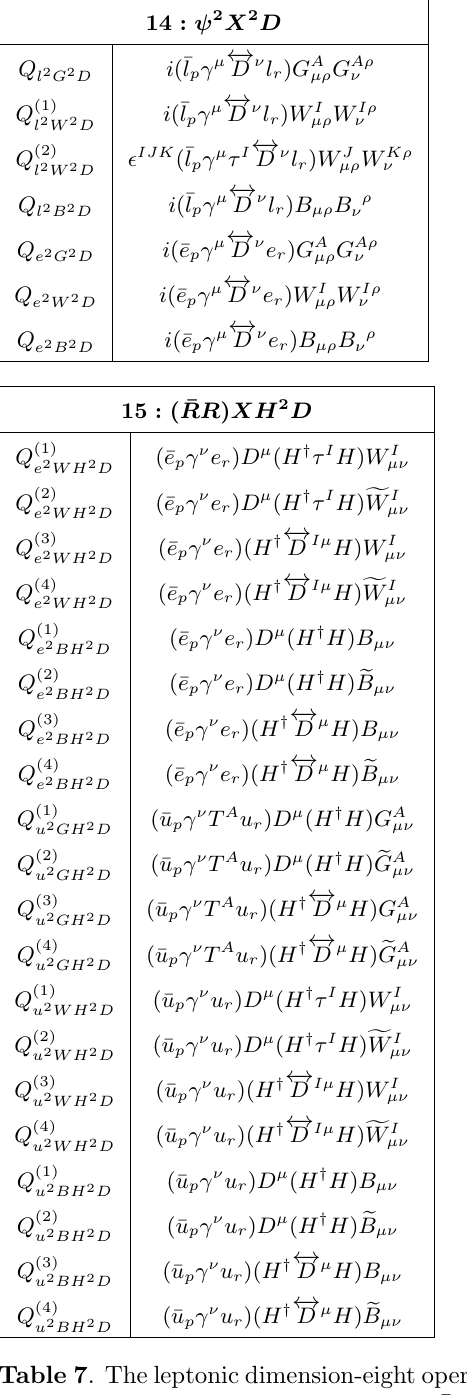
have distinct Hermitian udXH 2